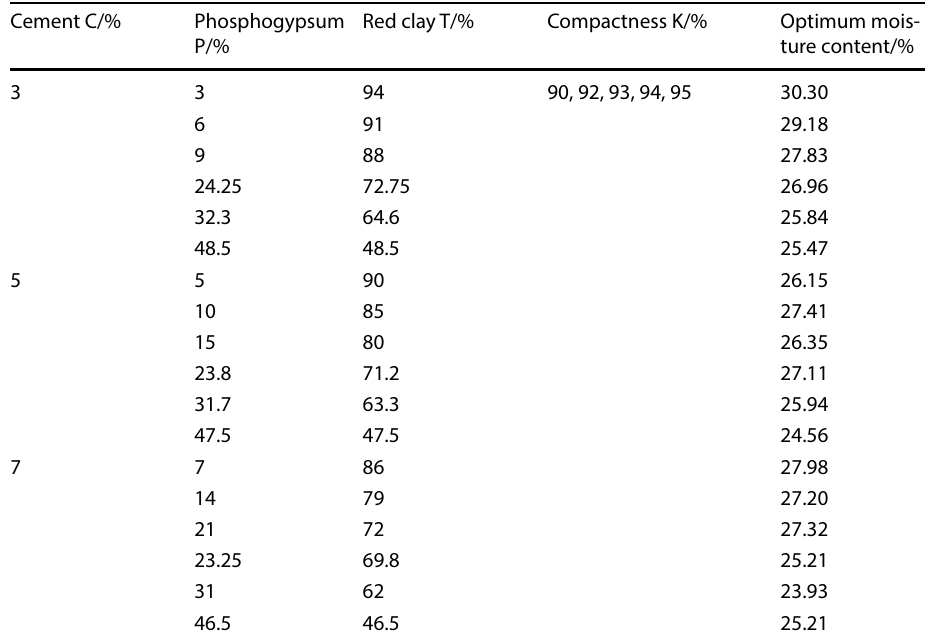
Table 4 Mix proportion design of mixture